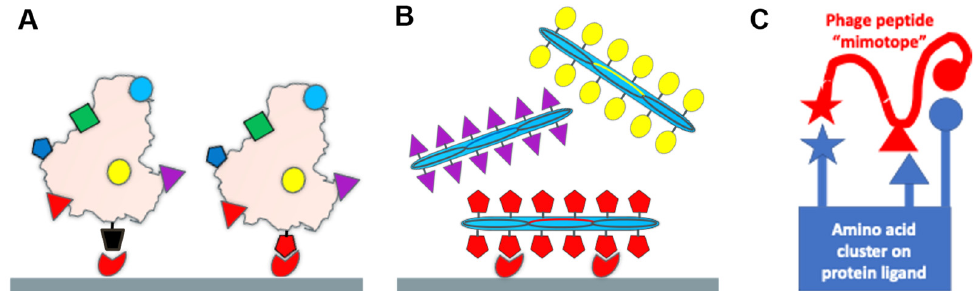
Figure 3. ( A ) Schematic of viral evolution (adaptation) leading to increased fitness to cellular receptors through diversification of viral functional domains; ( B ) schematic of SARS-CoV-2 functional domains and epitopes (or their mimetics) fused to p8 proteins and selected from landscape phage libraries through phage mimicry; ( C ) the phage-displayed peptide (mimotope) contains the same or similar amino acid (AA) residues as amino acid clusters (AA clusters) on the surface of spike protein, and presumably can interact with viral cellular receptors.